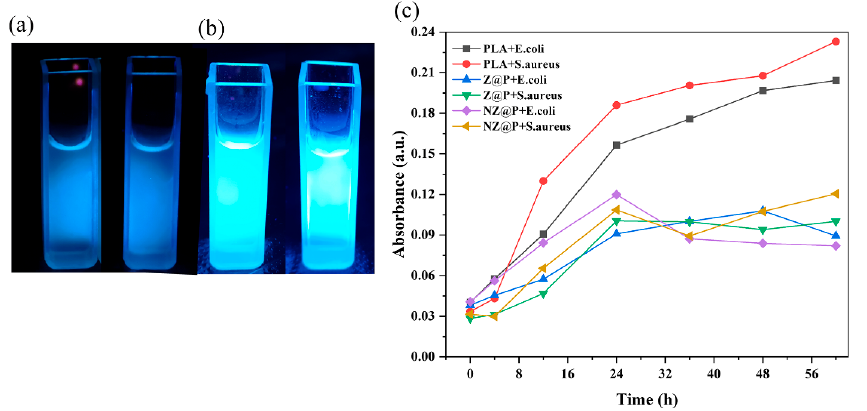
Figure 9. PLA composite films immersion solution image under UV light: ( a ) ZIF-L@PLA film, ( b ) NCDs@ZIF-L@PLA film, and ( c ) OD 600 values of PLA composite films co-cultured with E. coli and S. aureus for 48 h.